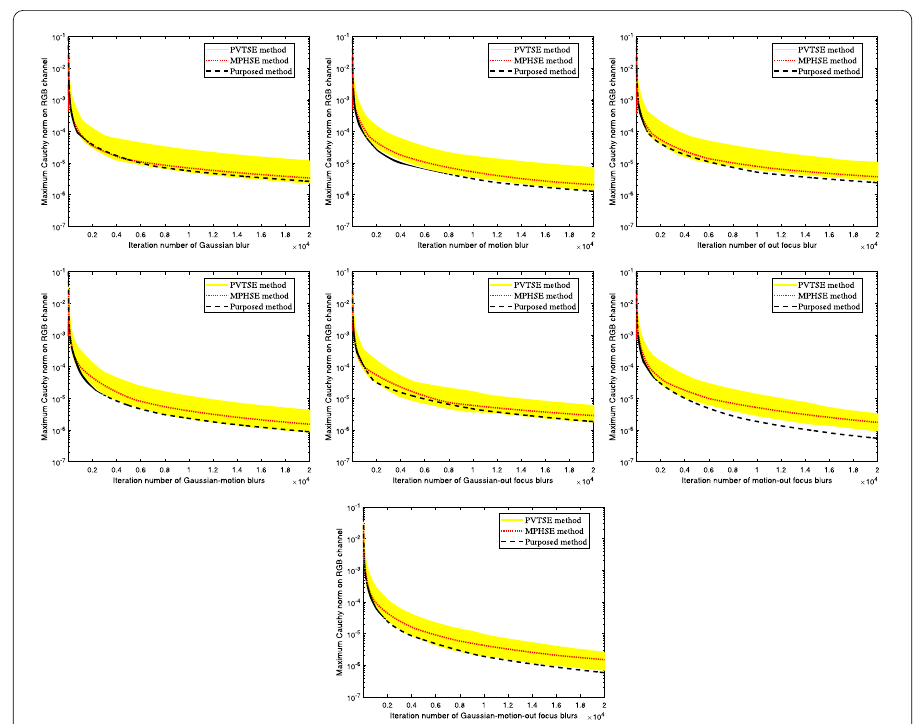
Figure 7 Cauchy error plots of PVTSE, MHPSE, and the proposed algorithms in all cases of RGB images